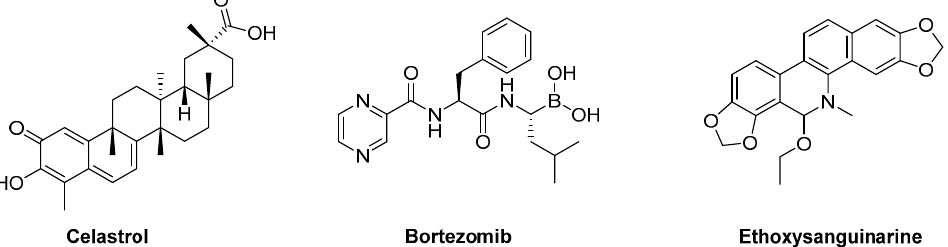
Figure 6. Selected PADs acting through the inhibition of CIP2A .